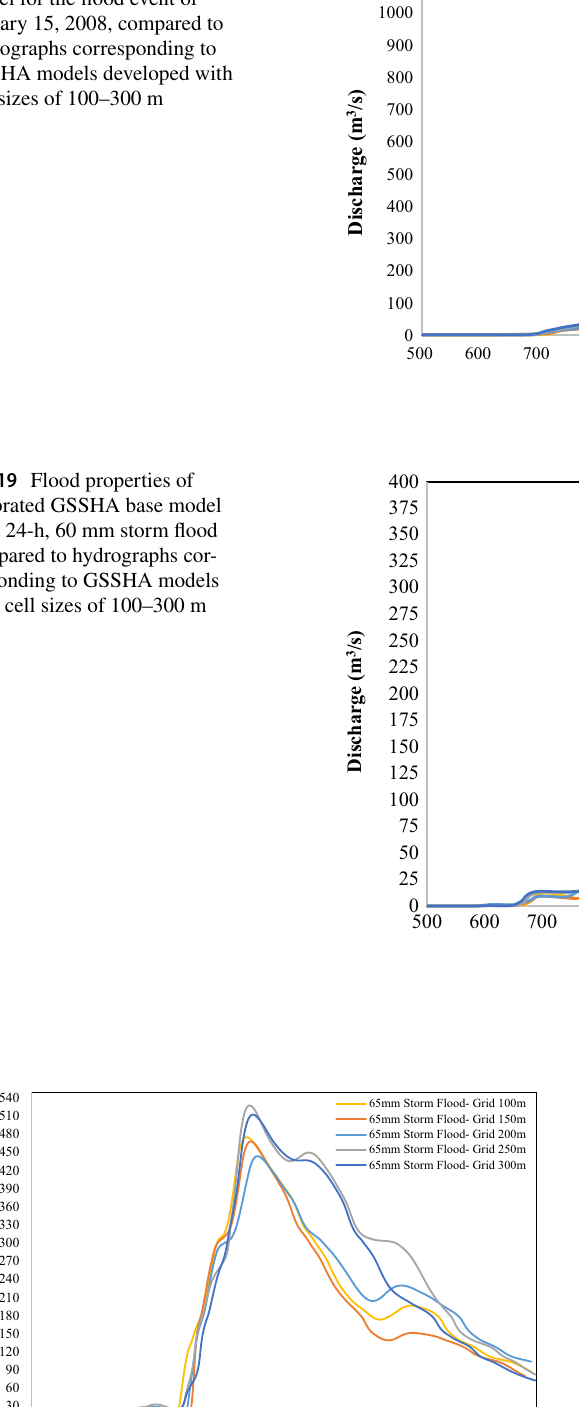
Fig. 18 Flood hydrographs of calibrated GSSHA base model for the flood event of January 15, 2008, compared to hydrographs corresponding to GSSHA models developed with cell sizes of 100–300 m